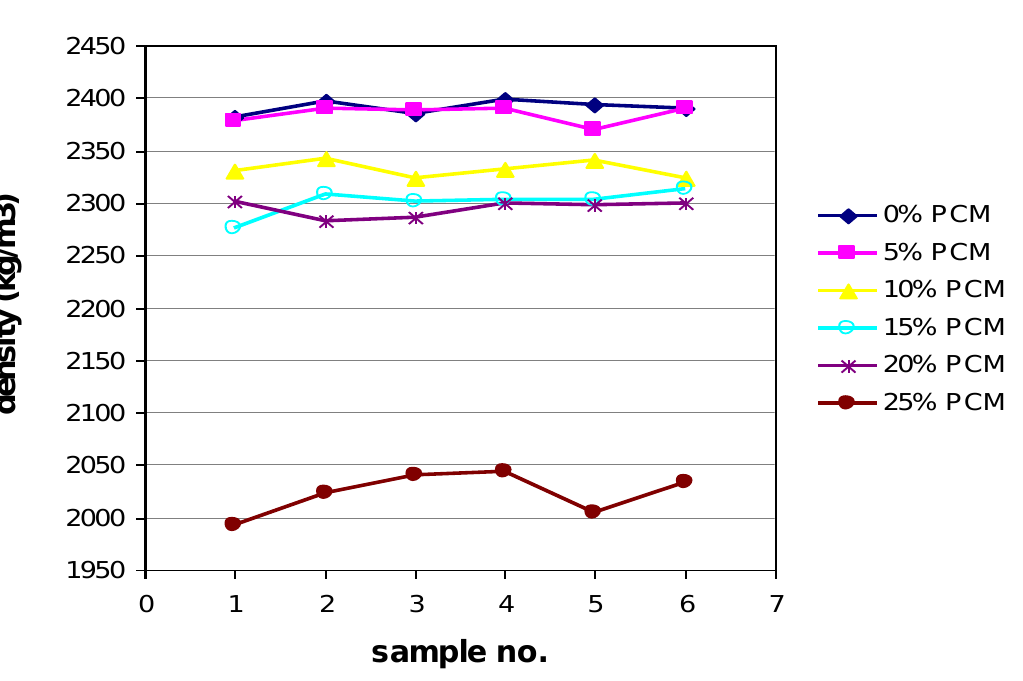
Figure 2. Densities by percentage of added PCM.